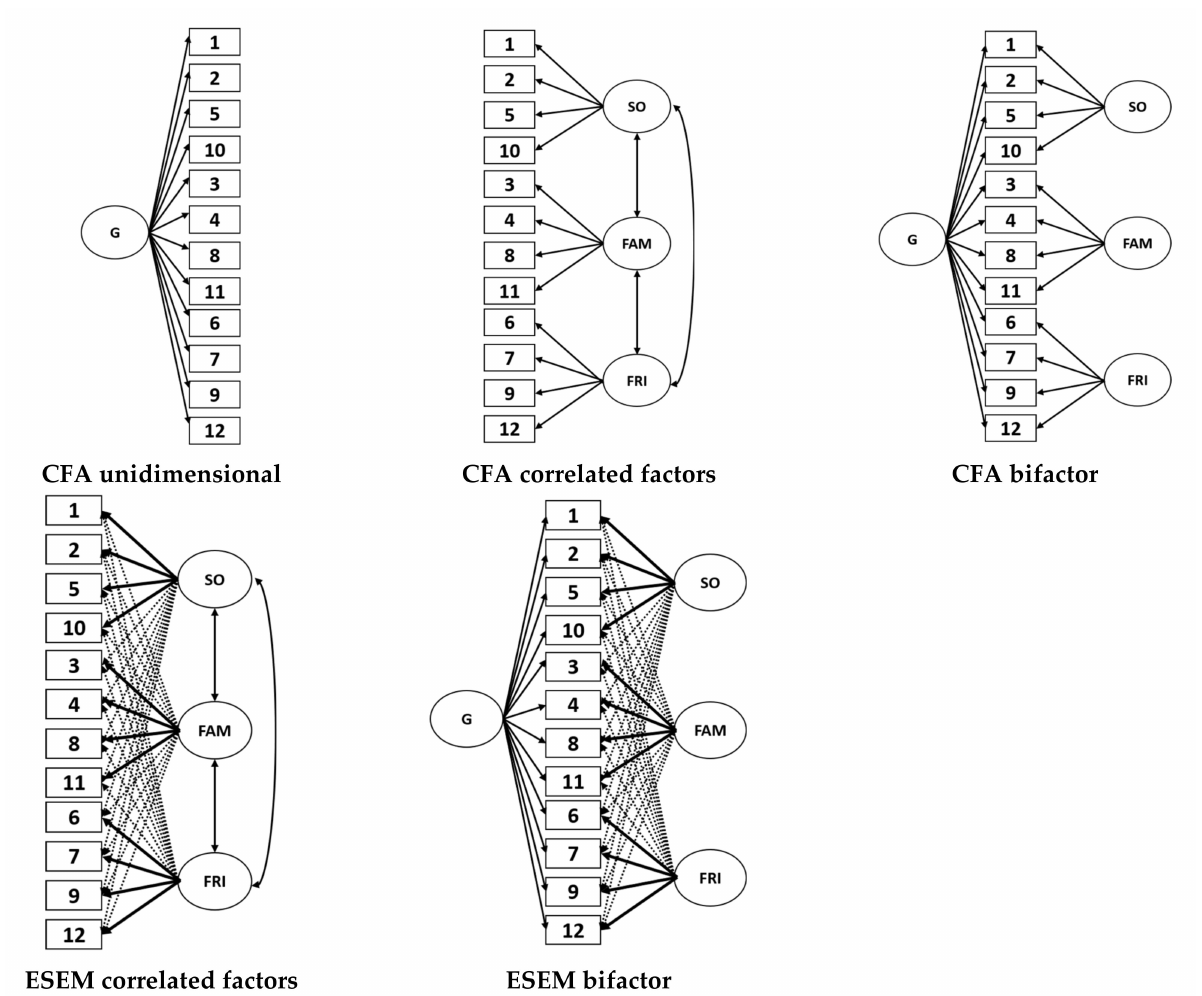
Figure 1. Representation of the CFA and ESEM models tested. G: General factor; SO: Others support factor; FAM: Family support factor; FRI: Friends’ support